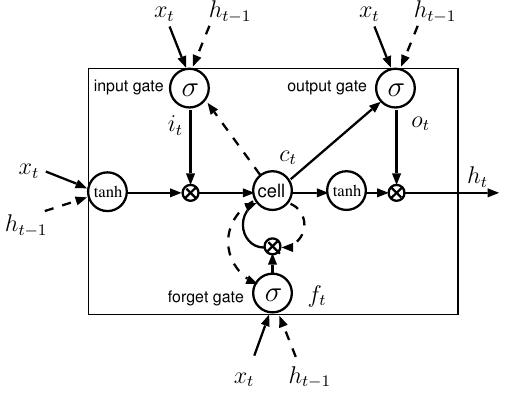
Figure 1: LSTM unit [2].